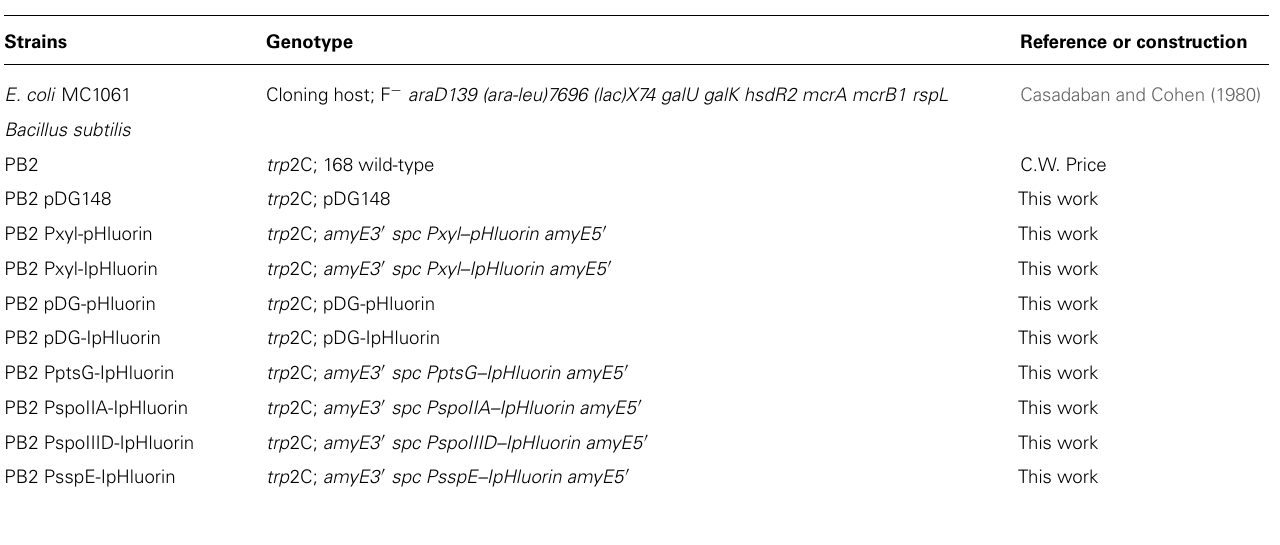
Table 1 | Strains used in this